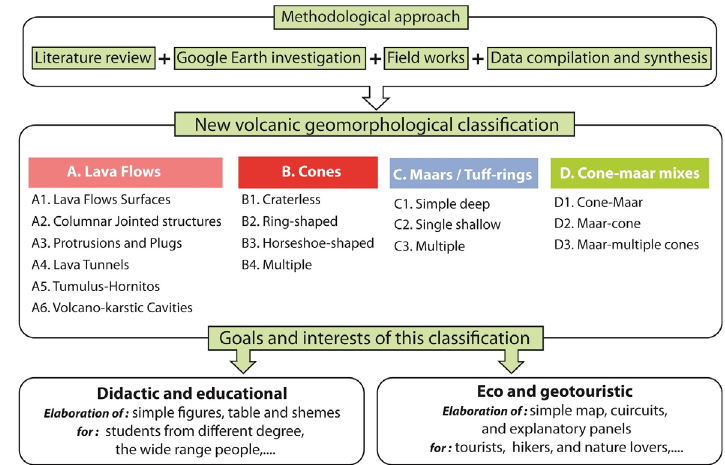
Fig. 9. Flow chart of used